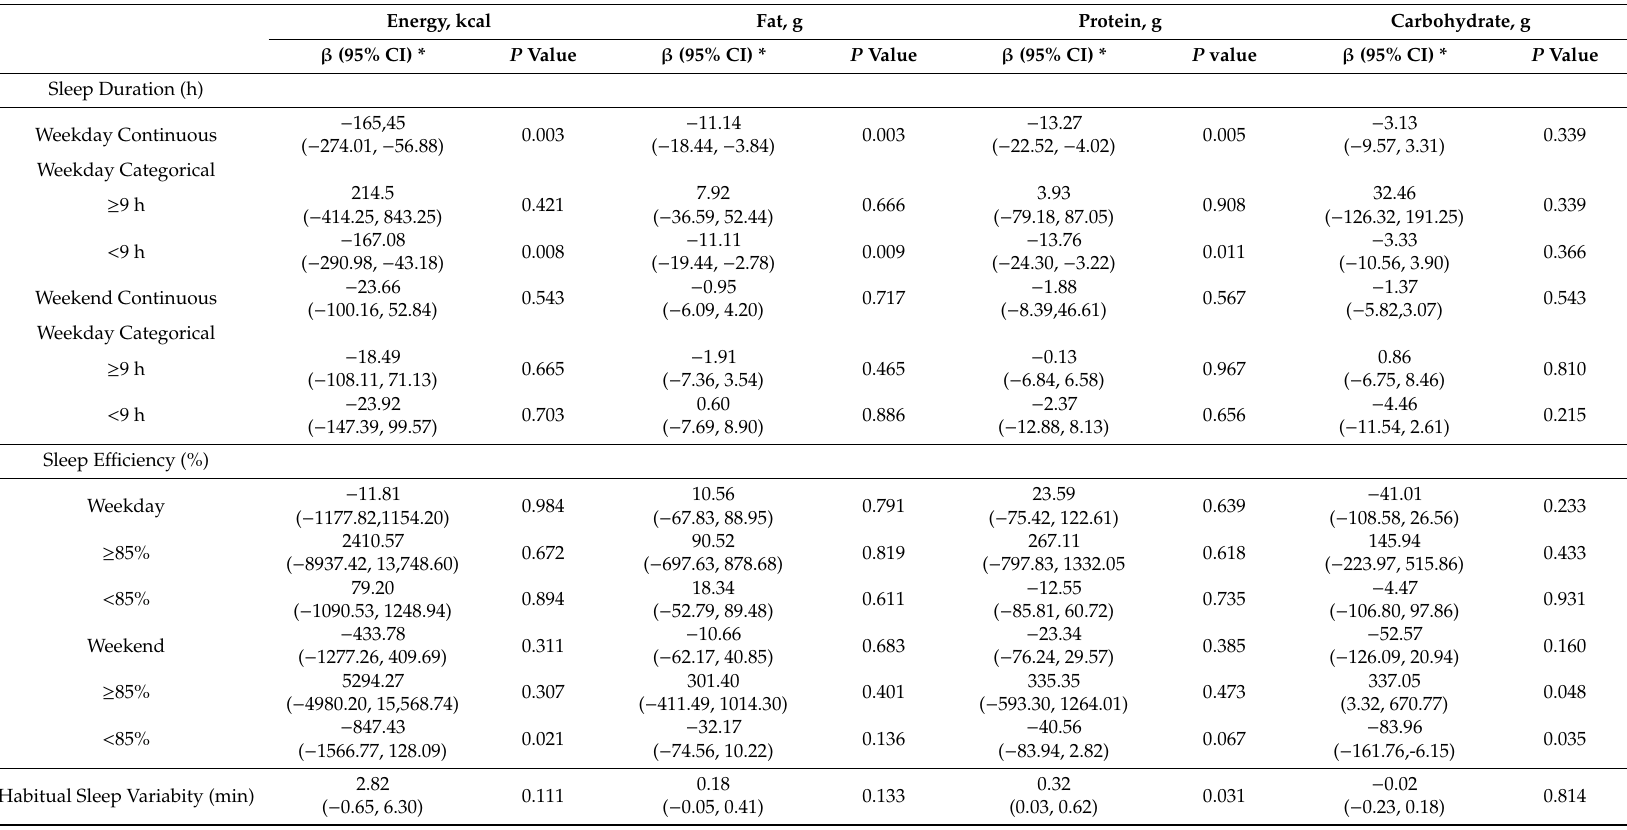
Table 4. Adjusted relationship between actigraphic sleep parameters and dietary